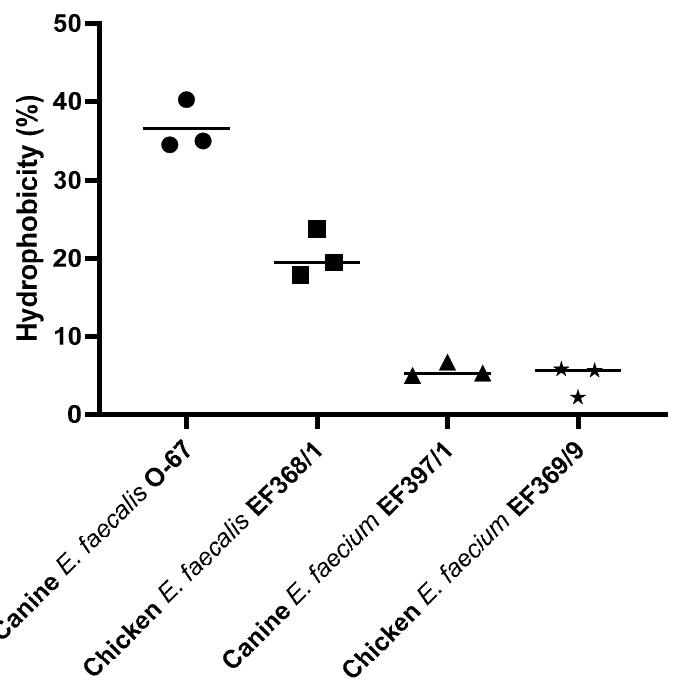
Figure 4. Hydrophobicity (%) of canine E. faecalis O-67, chicken E. faecalis EF368/1, canine E. faecium EF397/1, and chicken E. faecium EF369/9. Scatter plot showing data from three repetitions with their mean values indicated by black lines.